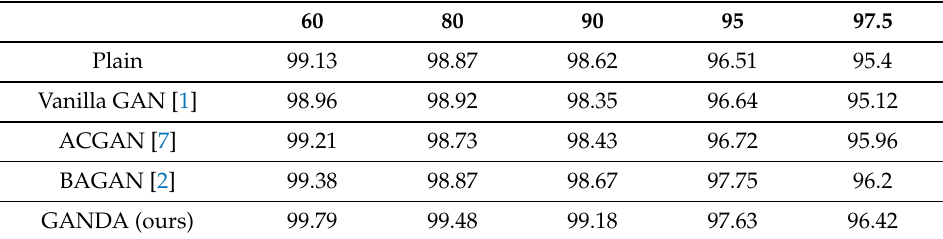
Table 4. The average accuracy (%) of the minority class achieved by the ResNet-18 classifier trained with the augmented MNIST dataset whose balance is restored after removing a portion of the minority class images.